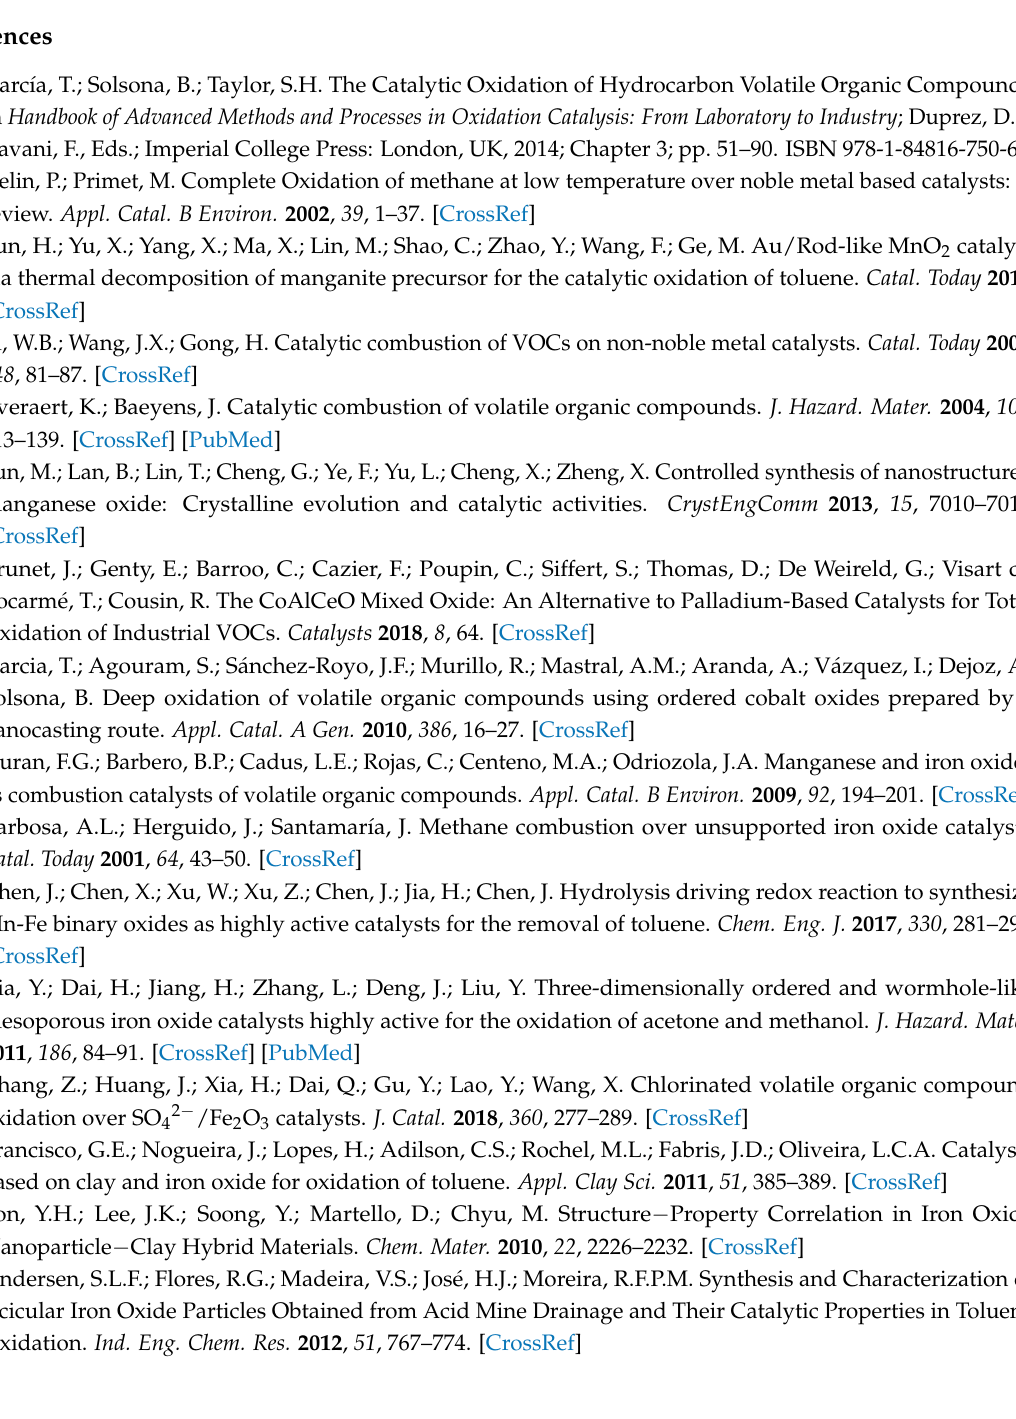
s1, Figure S1: TGA and FTIR spectra of fresh and used Fe-ST1